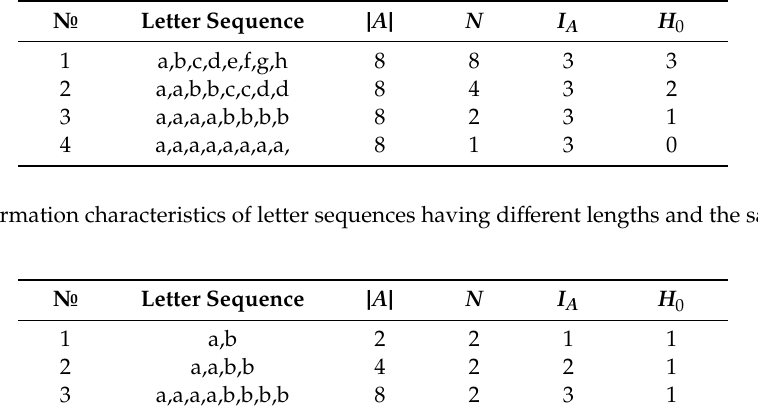
Table 1. Information characteristics of letter sequences having the same length and a di ff erent variety of letters. №